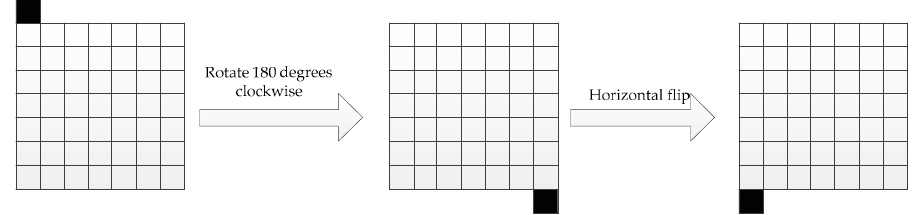
Figure 8. The procedure of transforming the shape from up-left into the standard shape down-left .